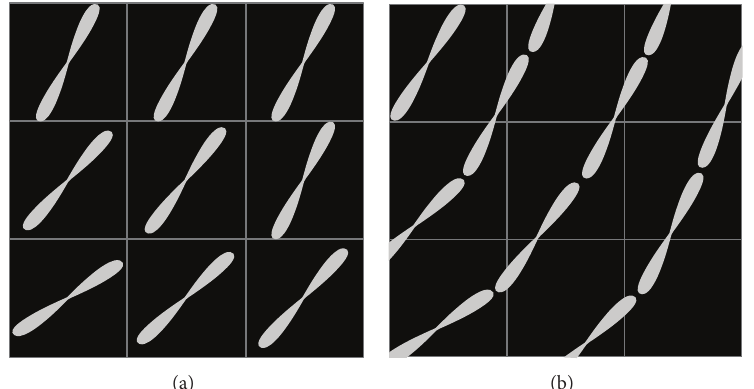
Figure 4: Comparison of input patterns using FOD glyphs: placement on regular grid (a) and continuous placement within superresolution grid